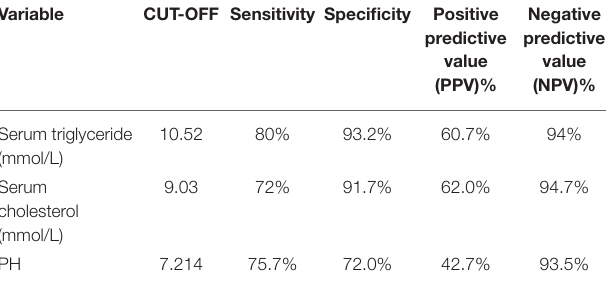
TABLE 5 | The predictive value of different indicators for DKA combined